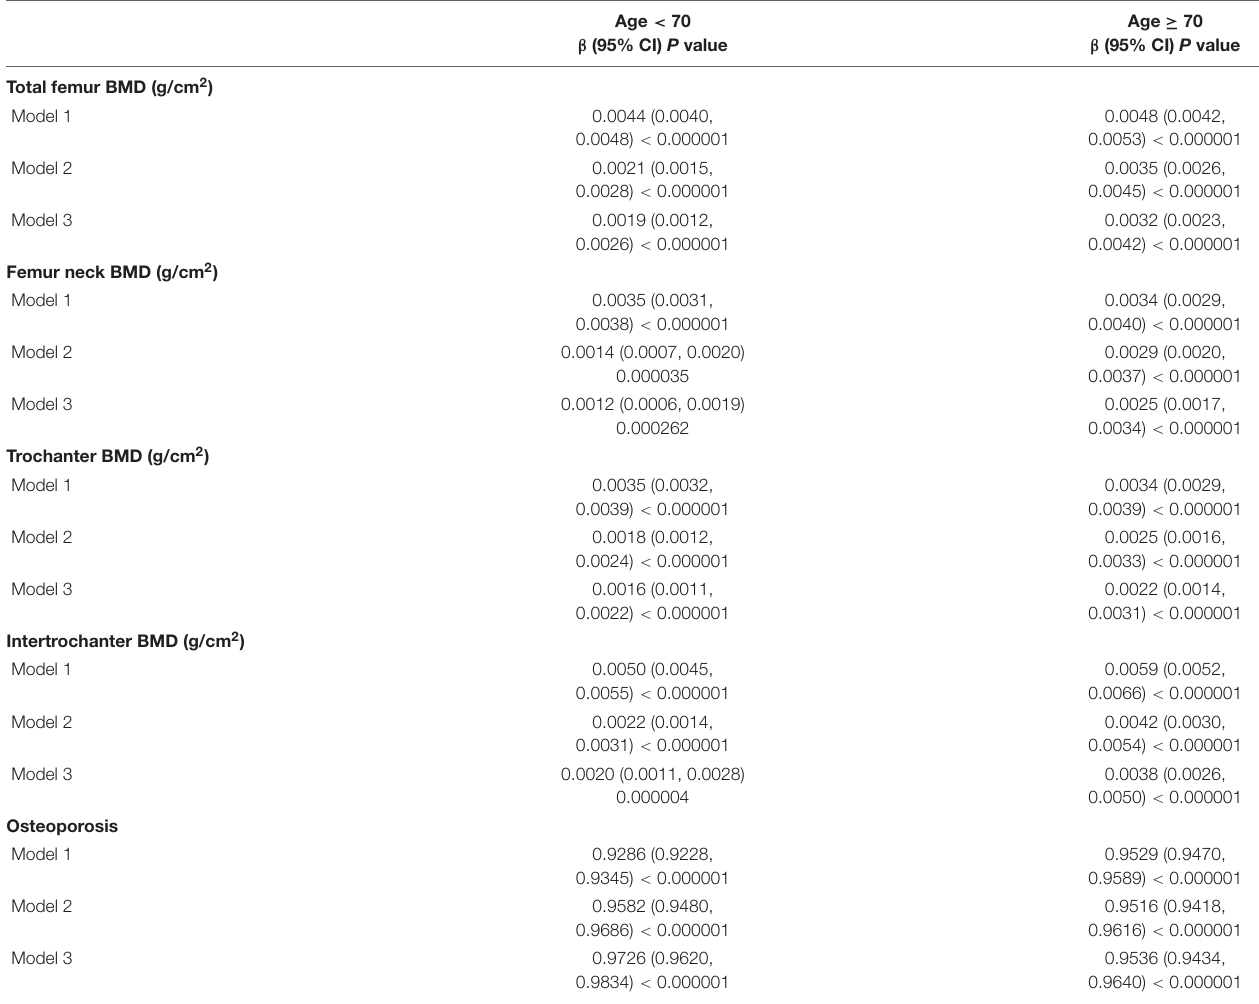
TABLE 4 | Associations of the GNRI with femur BMD and the risk of osteoporosis stratified by